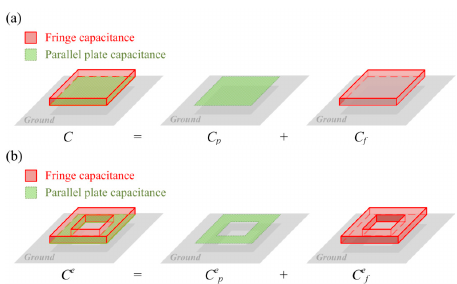
Figure 4. ( a ) Capacitance analysis of the non-etching-hole unit module; ( b ) Capacitance analysis of